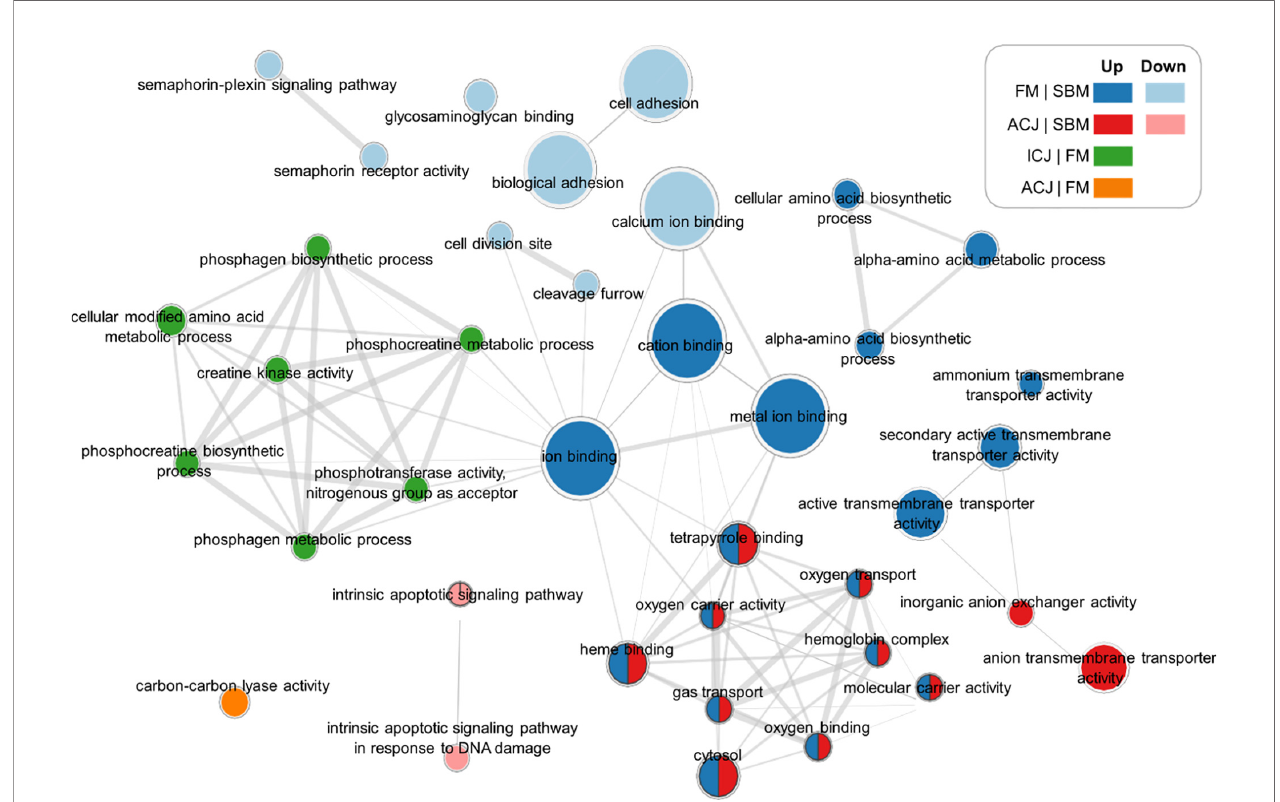
FIGURE 3 | Signi fi cant networks of enriched GO terms related to comparisons between different diets. FM|SBM: Up (up-regulated in blue), Down (down-regulated in light blue). ICJ|FM: Up (up-regulated in green). ACJ|FM: Up (up-regulated in orange). ACJ|SBM: Up (up-regulated in red), Down (down-regulated in pink).